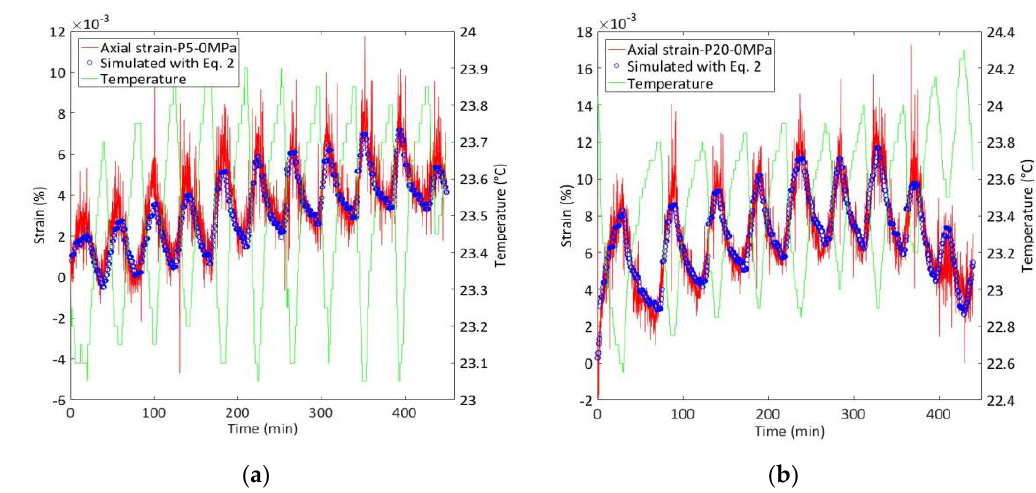
Figure 8. Axial strain deformation of ( a ) LSCF-P5 and ( b ) LSCF-P20 samples without applied compression stress superimposed with a simulated strain and temperature measurement during the experiment.